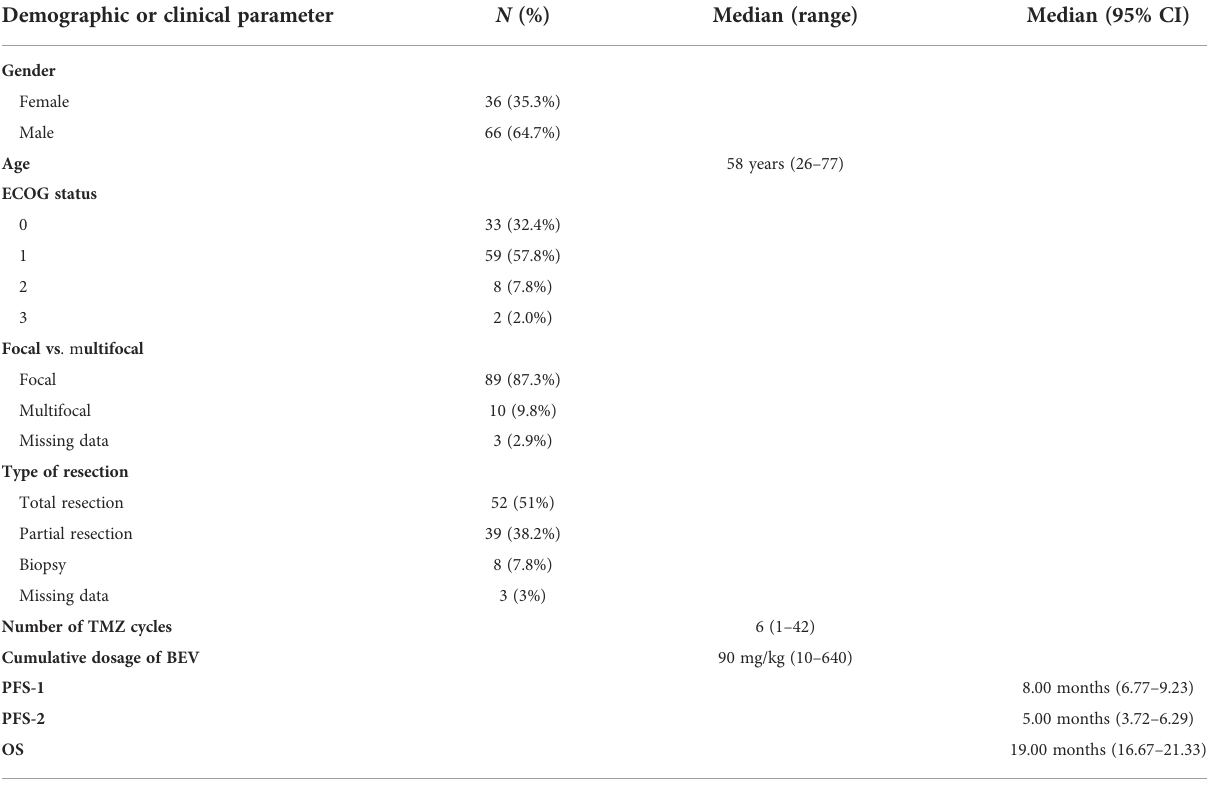
TABLE 1 Demographic and clinical parameters of the cohort.